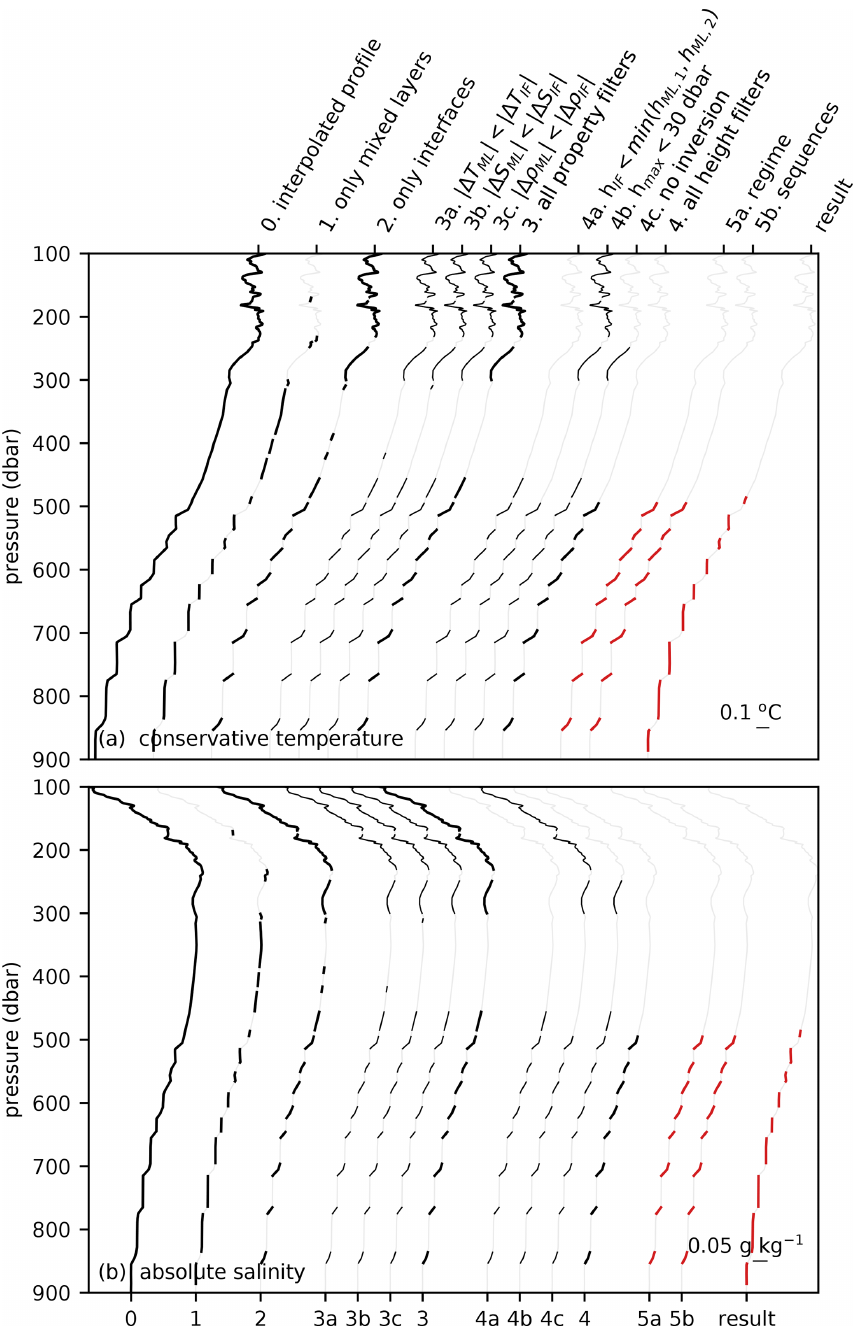
Figure A2. As Fig. A1, but for a profile in the Mediterranean Sea. Original profile is taken from Argo float 6901769 at 8.9 ◦ E and 37.9 ◦ N on 31 October